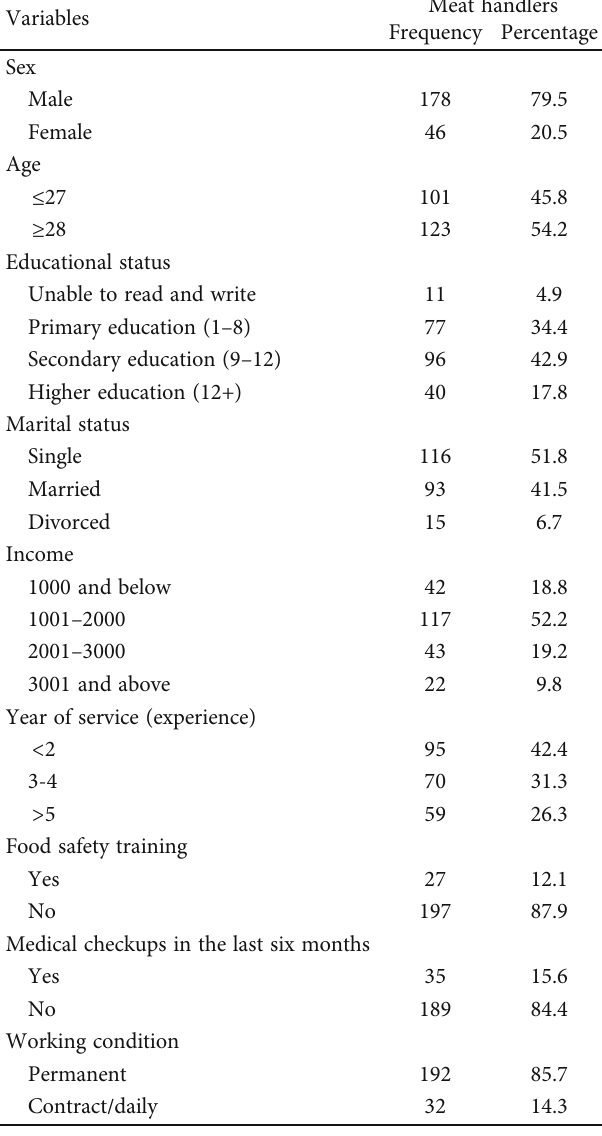
Table 1: Sociodemographic characteristics of meat handlers working in butcher shops in North Shewa Zone ( n = 224